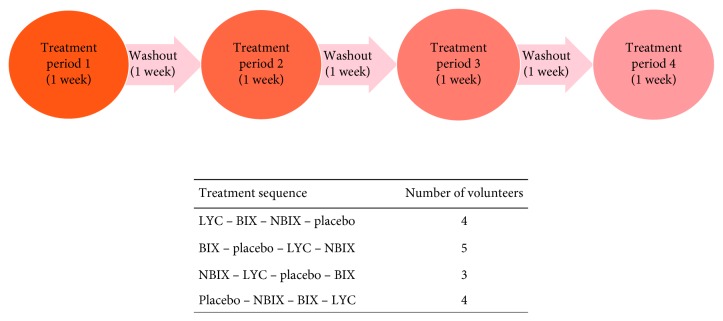
Representative figure of treatment sequence followed by volunteers.